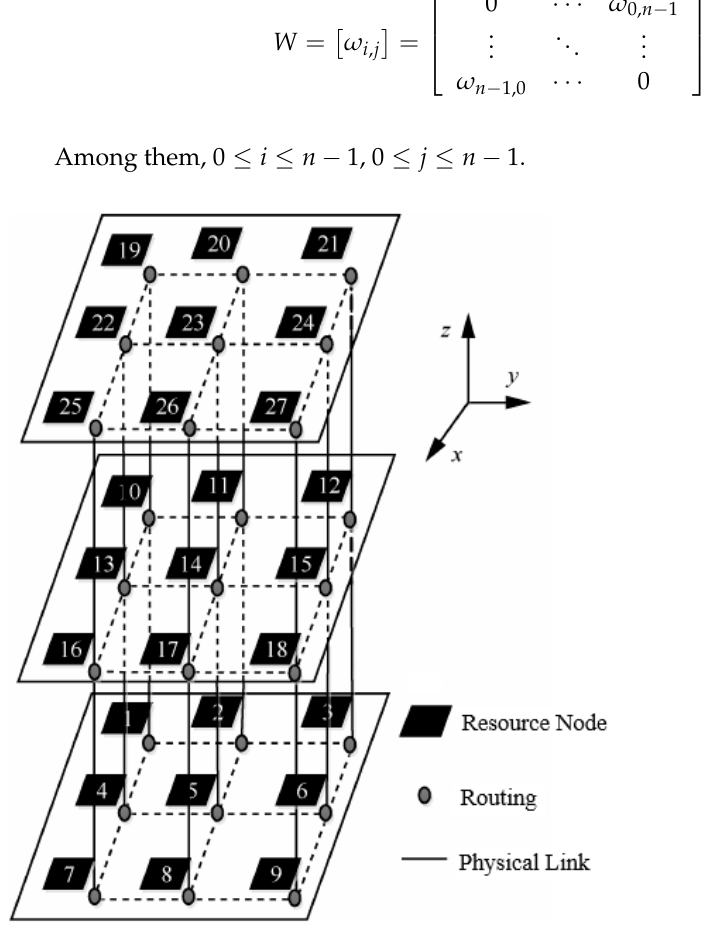
Figure 1. Architecture Characteristic Graph.